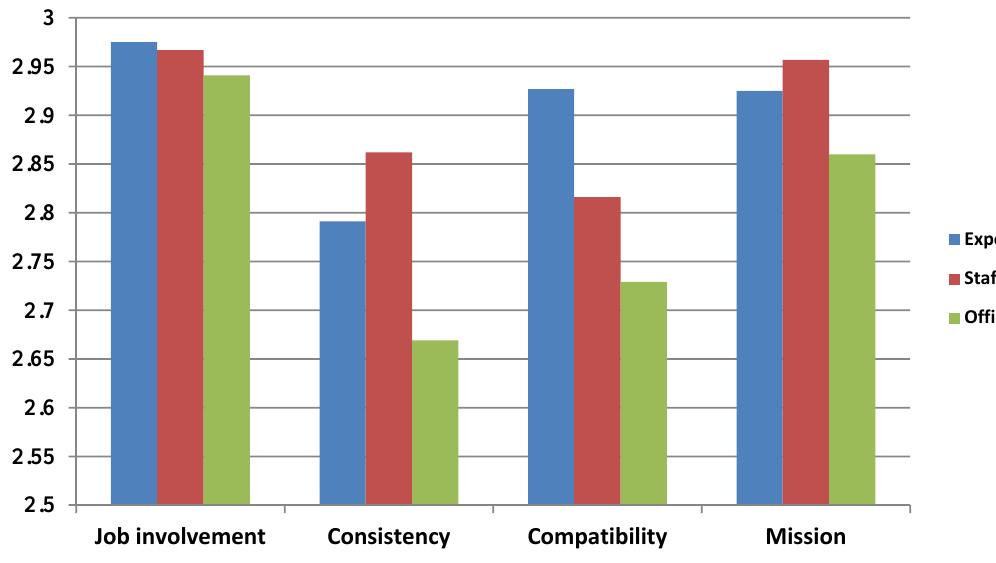
Fig. 3. The mean scores given to experts, staff and